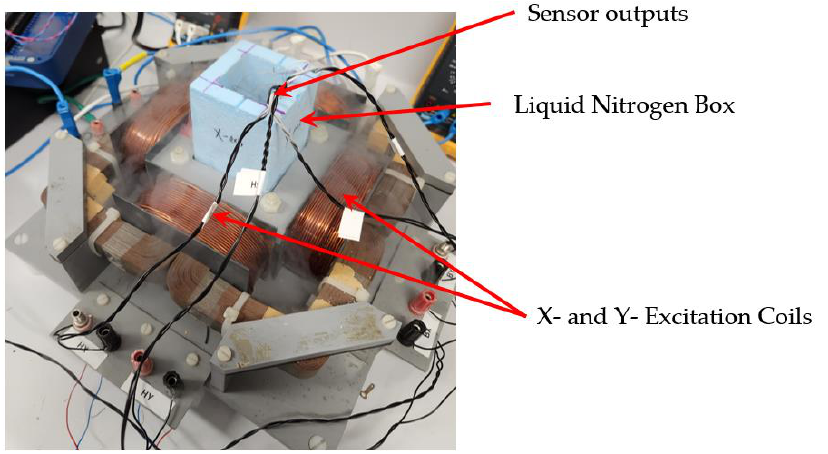
Figure 4. An image of the tester during experiment.